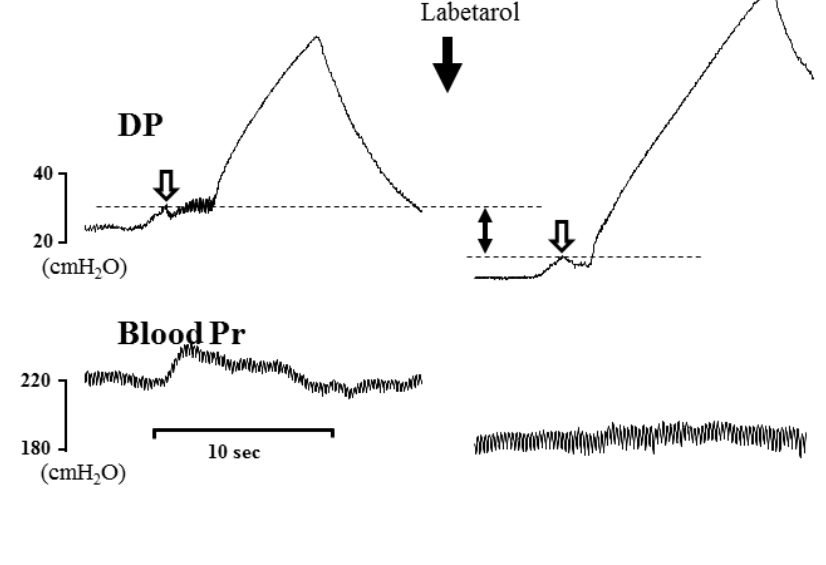
Figure 4. Representative cystometrogram showing simultaneous arterial pressures and flow pressure by detrusor pressure before and after the arterial injection of 5 mg·kg −1 labetalol in conscious SHRs. DP: detrusor pressure; Pr: